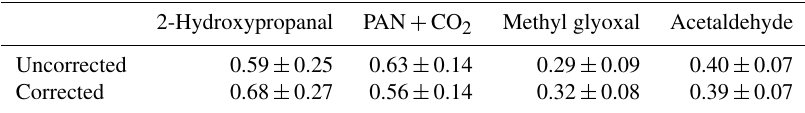
Table 3. Uncorrected yields and first-generation yields (yields corrected for secondary processes) of species identified in the 3P2 + OH